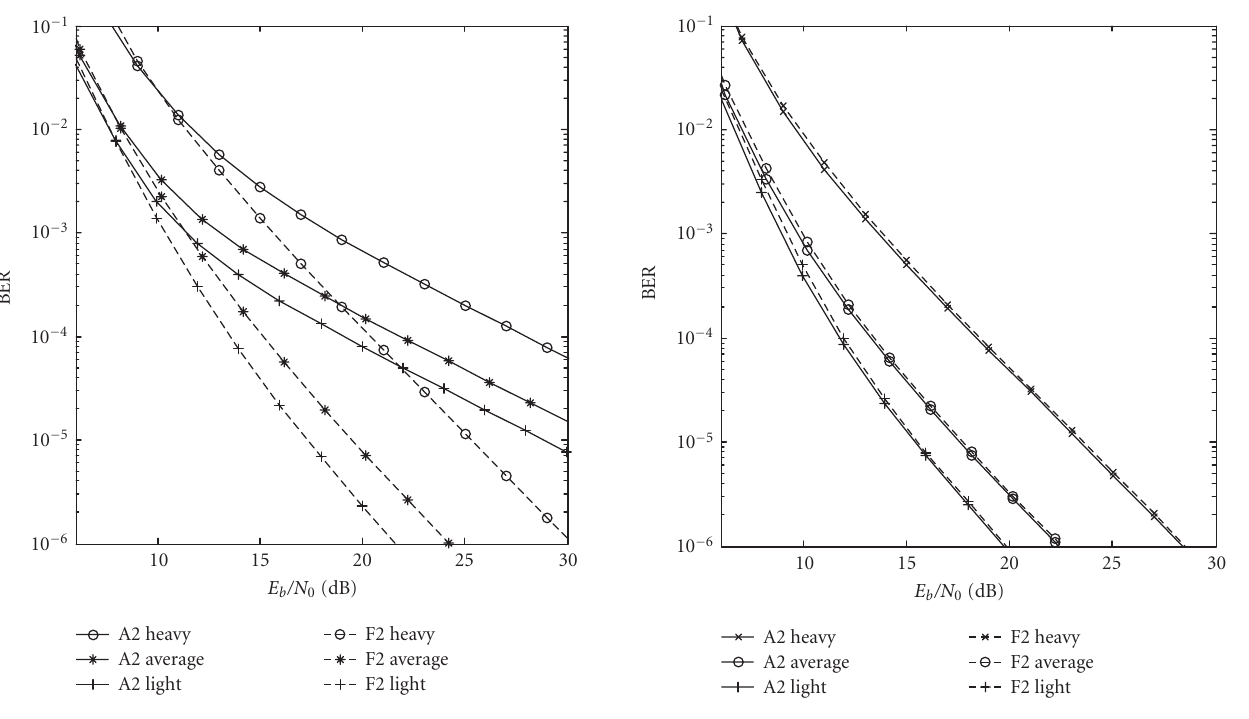
Figure 3: Upper bounds for concatenated MTCM-STBC schemes with codes A2 and F2 as outer codes over shadowed Rician channels (2-TX and 1-RX antenna).